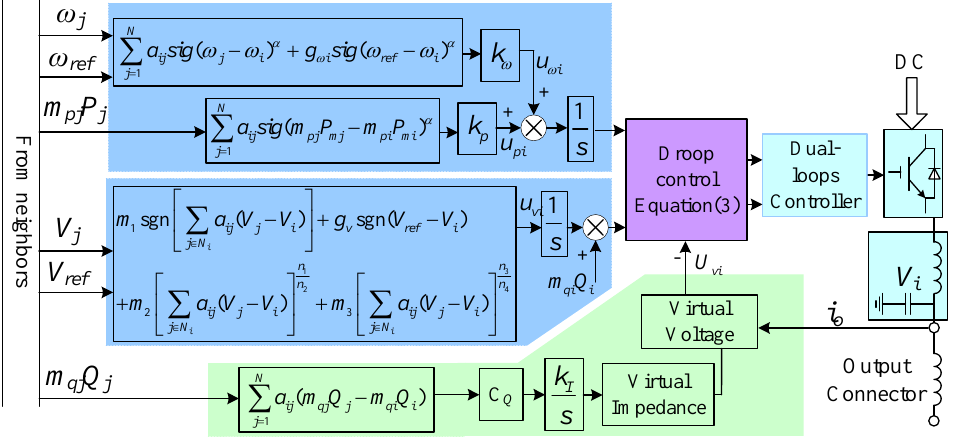
Figure 2. Block diagram of the distributed finite-time secondary